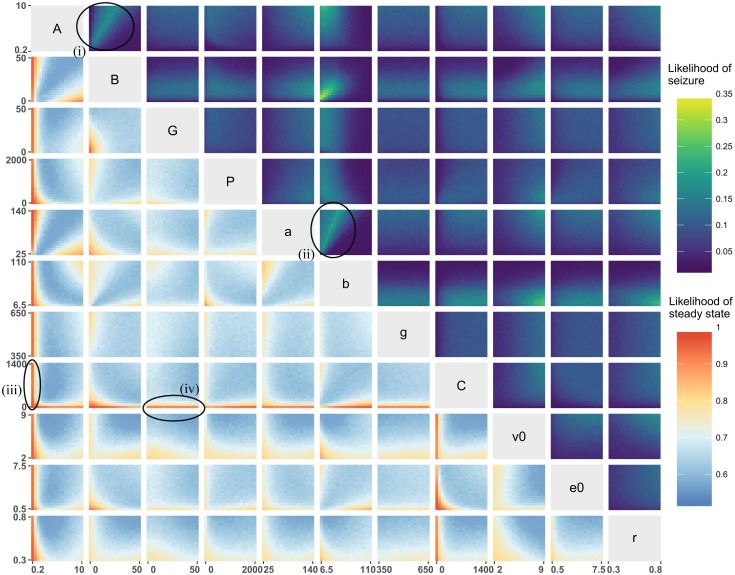
Bivariate joint distribution of the likelihood of steady state (lower triangle) or seizure dynamics (upper triangle).Each subfigure is a projection of the parameter space over two parameters, and the colour indicates the likelihood of finding a particular type of dynamics (seizure or steady state) as per the colourbar. For example, the subfigure in the second column on the first row (encircled and labelled (i)) maps the likelihood of finding seizure dynamics over different values of B(x-axis) and A(y-axis), given variations in all other parameters. In the upper triangle, yellow indicates high likelihood of observing seizure dynamics, whereas blue indicates low likelihood of observing seizure dynamics. In the lower triangle, red indicates high likelihood of observing steady state dynamics, whereas blue indicates low likelihood of observing steady state dynamics. Each subfigure was computed using eq 12 with 20 × 20 bins over the parameter ranges provided in Table 2. Upper triangle: Specific combinations of parameters can lead to manifolds with a high likelihood of seizure dynamics (see for example the linear relationships between A and B in the encircled subfigure (i) and a and b in the encircled subfigure (ii)). Lower triangle: one can observe that small values of the parameters A or C guarantee a steady state (see for example the encircled subfigures (iii) and (iv)).